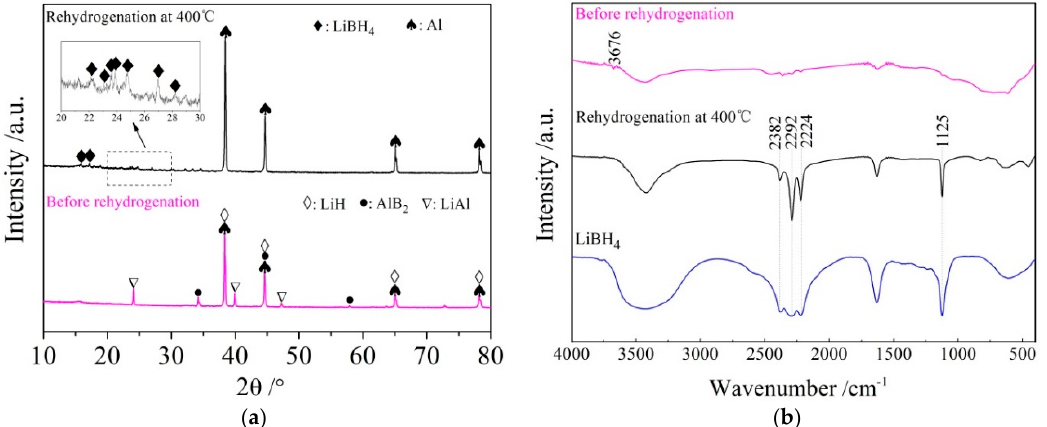
/ Al* sample before and after 4